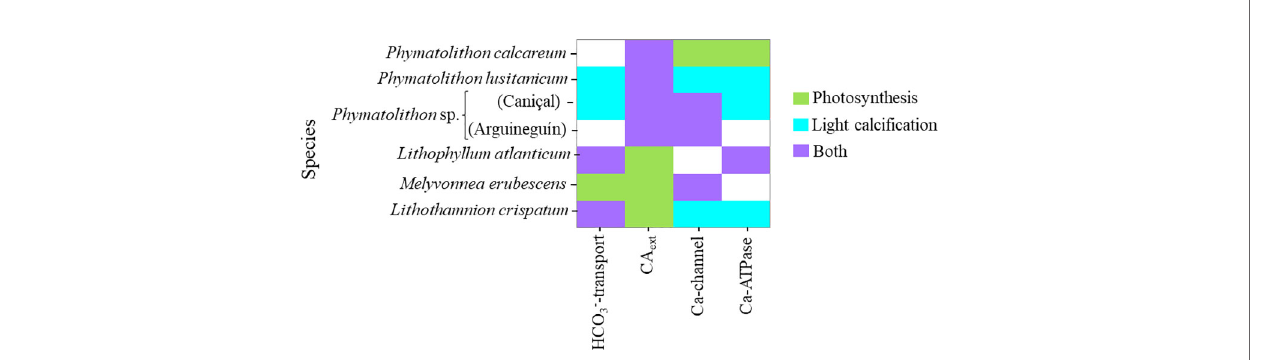
FIGURE 8 | Summarized overview of the importance of CA ext and speci fi c ion-transporters for rhodolith photosynthesis and/or calci fi cation, based on inhibitor effects and accounting for declines in calci fi cation caused indirectly by inhibitor effects on photosynthesis ( “ Both ” - inhibitor effect on both processes, but larger in calci fi cation, indicating direct effect on the latter; Supplementary Tables S3 – S5